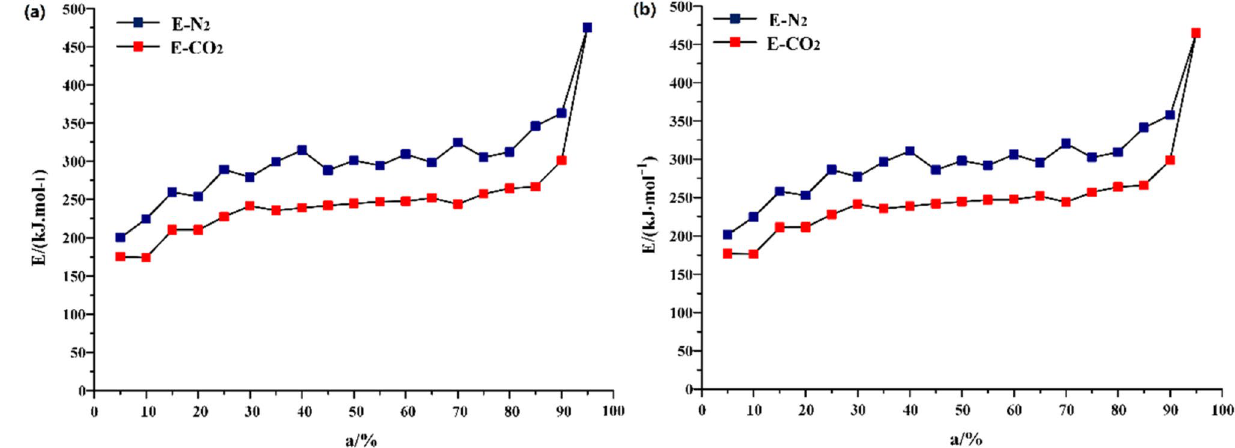
Figure 7. Activation energy of Huadian oil shale pyrolysis during the stage II ( a ) KAS ( b ) FWO.